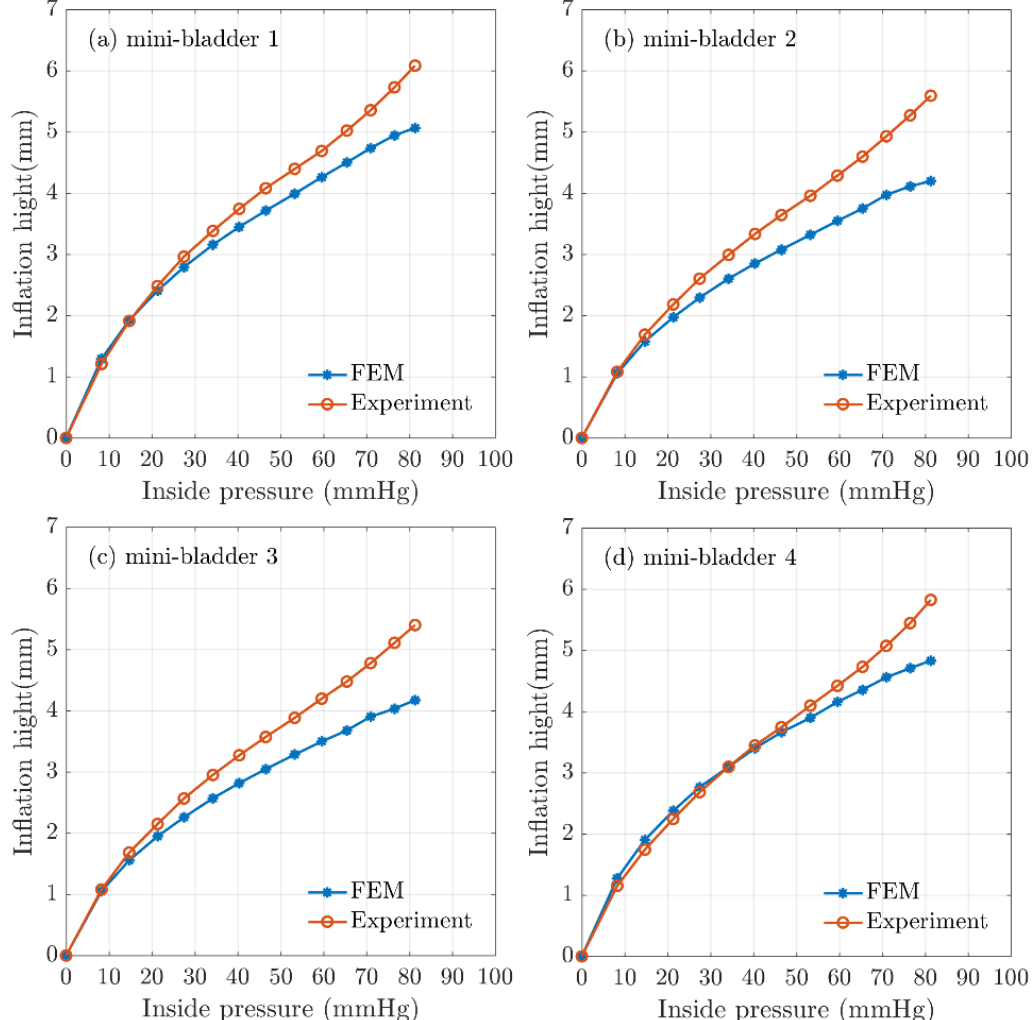
Figure 7. Comparison of FEA results for inflation height and experimental mean height for hexagonal mini-bladder unit against the pressure between 0mmHg and 85 mmHg. Experimental data are shown in orange (mean height values) and the model values shown in blue for ( a ) mini-bladder 1, ( b ) mini-bladder 2, ( c ) mini-bladder 3, and ( d ) mini-bladder 4.